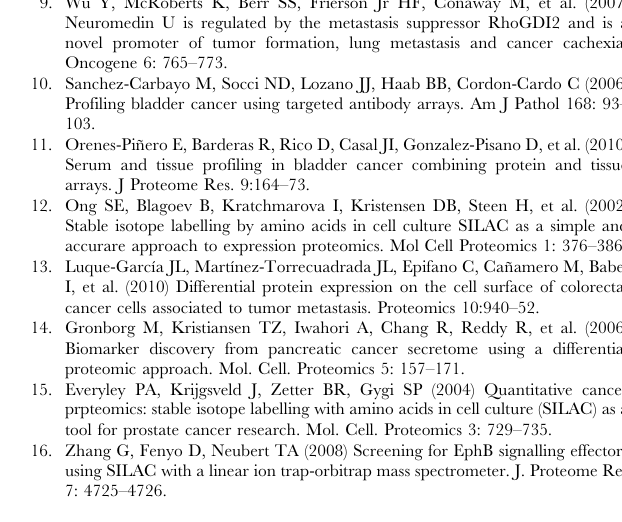
Table S2 Protein ID and quantification. Proteins are listed alphabetically according to Protein Name. Proteins were identified according to the NCBI human databases (NCBI GI # s given for each ID). The table includes the corresponding UniProt and IPI accession numbers where available, Mascot scores corresponding to the highest scoring occurrence of a given protein or peptide, and GO annotations. T24T/T24 SILAC ratio = Intensity of the heavy peptide (C 13 )/Intensity of the light peptide (C 12 ). Table S3 Detailed information of ratios obtained from the proteins identified by SILAC (831 proteins, first sheet) and those measured simultaneously by oligonu- cleotide arrays (438 proteins, second sheet), including probe identification and gene description of the oligo- nucleotide